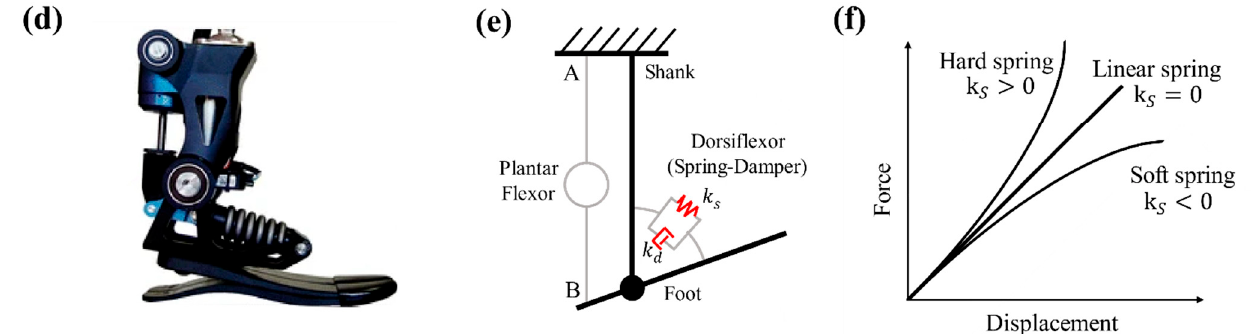
Figure 1. Flexible material ( a ) under stretching condition; ( b ) Cross-linked nanocomposite chains using spring-based interaction: ( c ) Uniaxial cycle response to show Mullins hysteresis effect behavior; ( d ) Powered ankle-foot prosthesis (image adapted from [28]); ( e ) Compliant dorsiflexor model with a spring-damper system in parallel configuration ( k s : elastic spring constant, k d : dashpot viscosity constant; ( f ) Curves of restoring spring force.